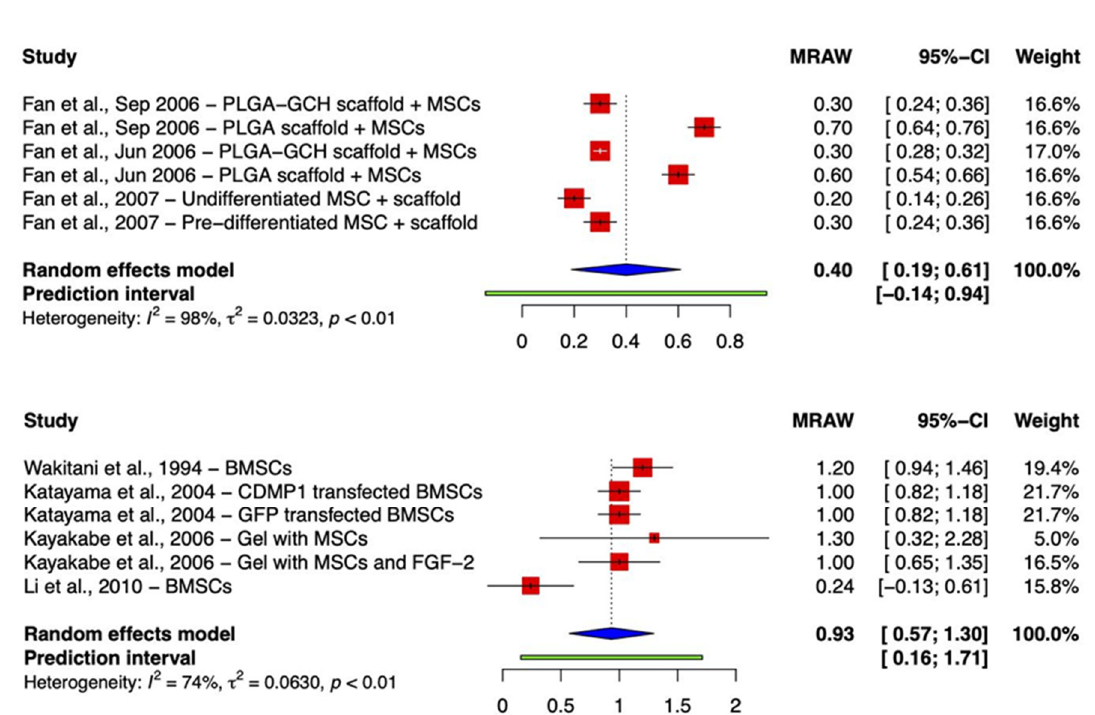
Figure 3. Forest plots representing subgroup meta-analyses of mean integration scores depending on whether scaffolds were composed of ( a ) PLGA or ( b ) other polymers. Lower scores equate to better outcomes, where 0/2 points = both edges integrated, 1/2 = one edge integrated, and 2/2 = no integration. (Abbreviations: BMSC, bone marrow-derived mesenchymal stem cell; CDMP1, cartilage-derived morphogenetic protein 1; GFP, green fluorescent protein; FGF-2, fibroblast growth factor-2; PLGA, poly-(lactic-co-glycolic acid); GCH, gelatin/chondroitin/hyaluronate; CI, Confidence Intervals) [22,24–28,30].